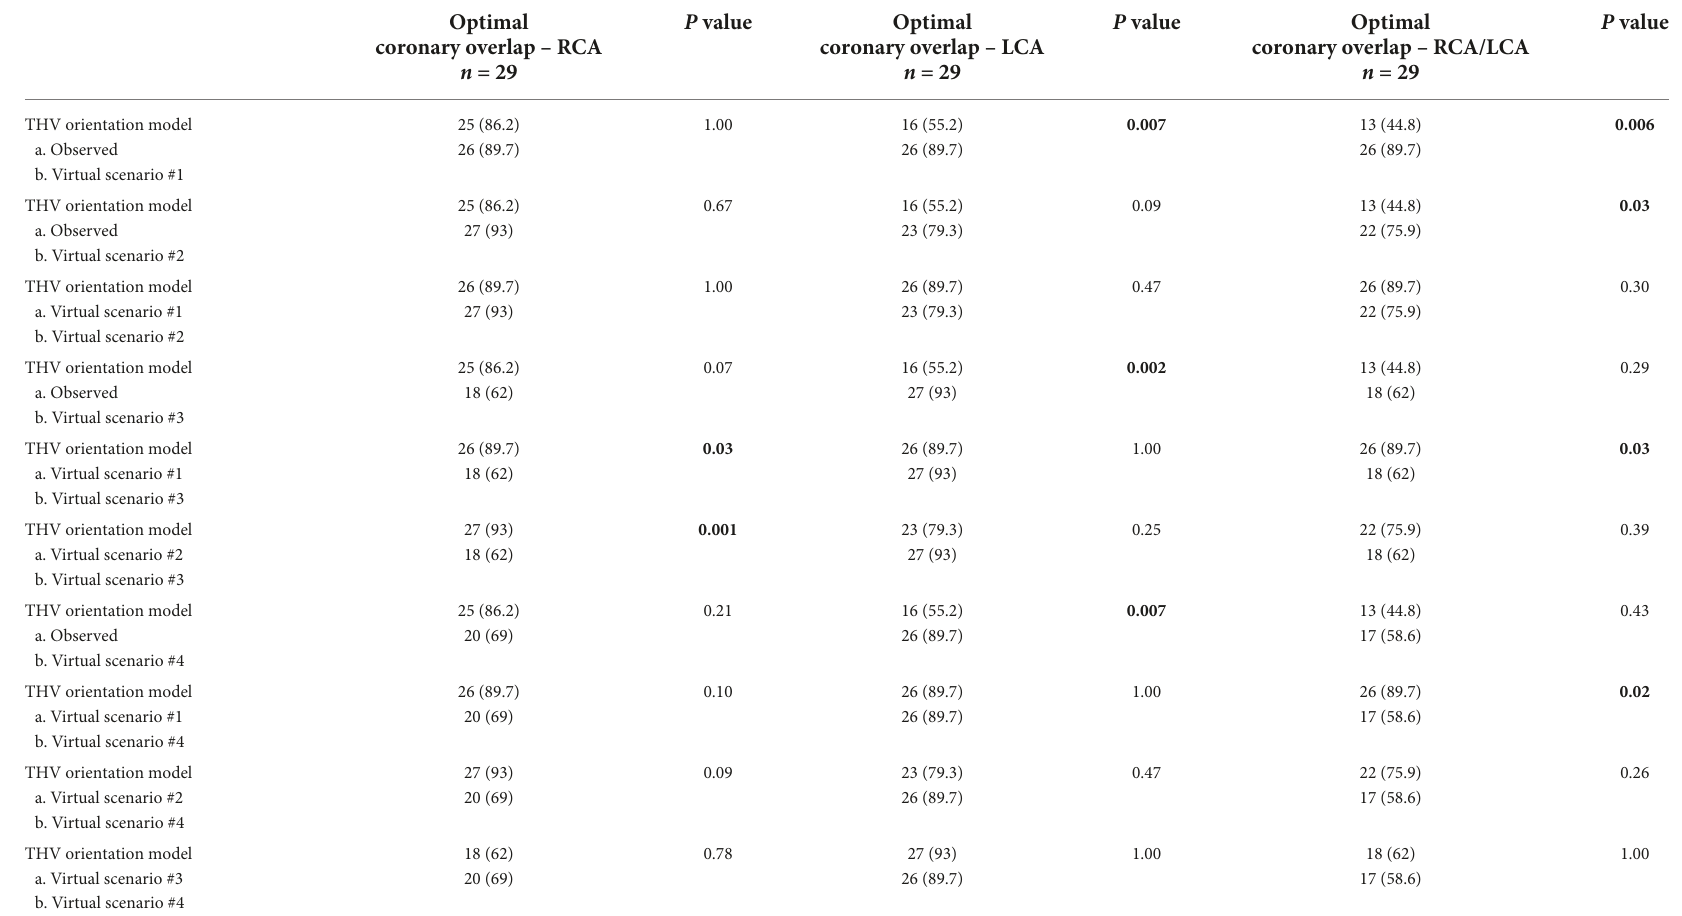
TABLE 5 Coronary overlap and THVs alignment